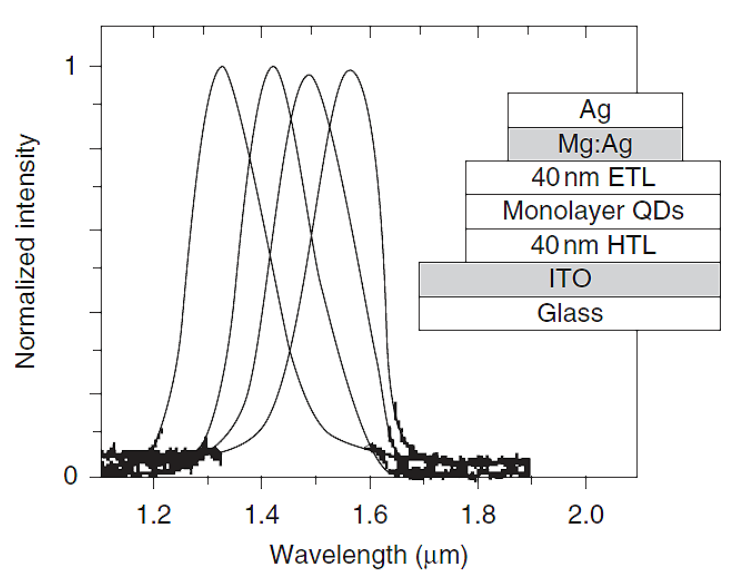
Figure 15. PbSe Qdots based Qdot-LED device structure and NIR-EL spectra using different sized Qdots (ETL: electron transport layer; QDs: quantum dots, HTL: hole transport layer, ITO: indium tin oxide) [Reproduced with permission from [165] Copyright Wiley-VCH Verlag GmbH & Co.